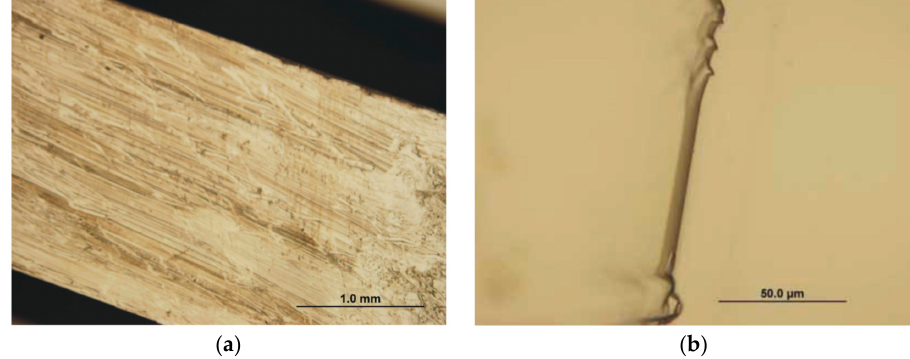
Figure 5. ( a ) Microscope images of substrate surface (5×) and ( b ) after growth thin film surface (20×) for Nd:YAB on a YAB substrate. The substrate is held vertically in the